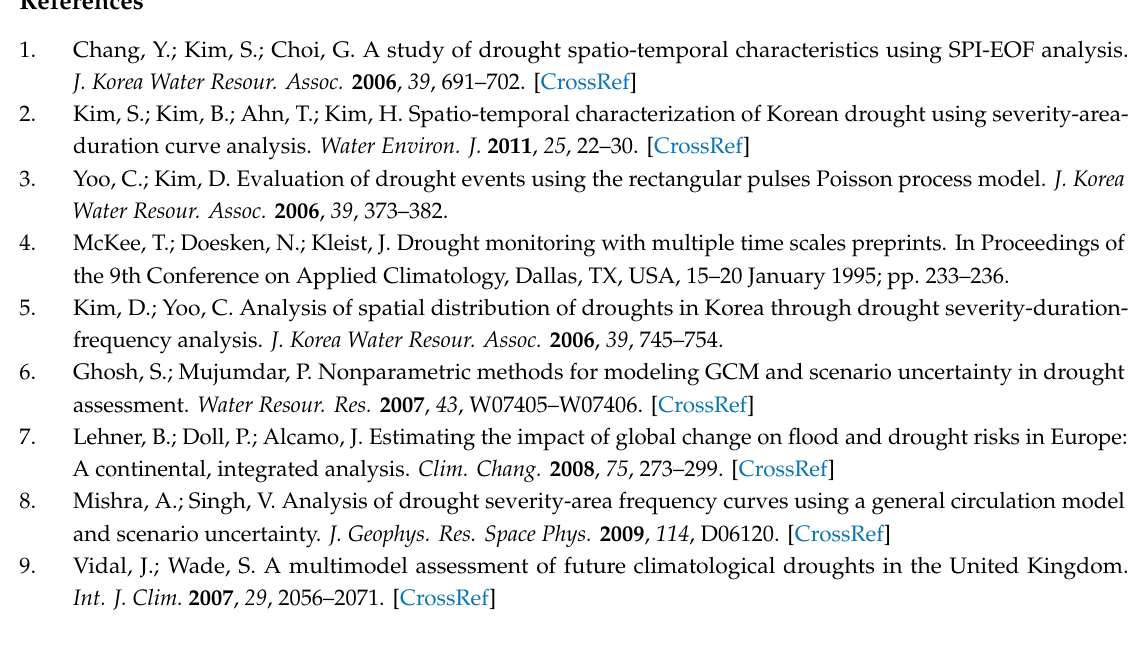
Figure S1: Partial duration series, Figure S2: Empirical and Gumbel distribution function of partial duration series, Figure S3: Probability distribution of drought severity samples, Figure S4: Probability distribution of drought duration samples, Figure S5: Relation between drought severity and